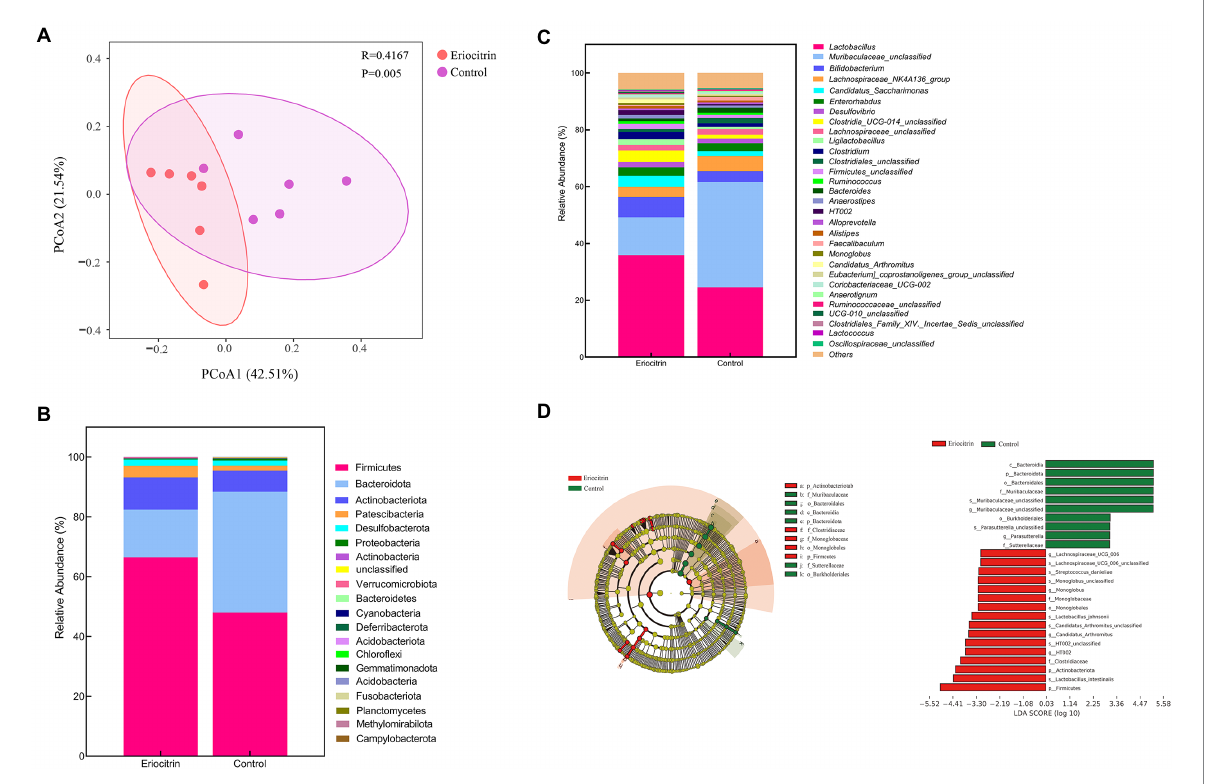
FIGURE 3 Dietary intervention with eriocitrin significantly alters the gut microbiota in mice. (A) Principal coordinates analysis (PCOA) based on UniFrac distance, each point represents a mouse sample. (B) Compositional change at the phylum level ( n = 6). (C) Compositional change at the genus level ( n = 6). (D) Gut microbiota genera differentially represented between eriocitrin and control groups (LDA > 3, p <